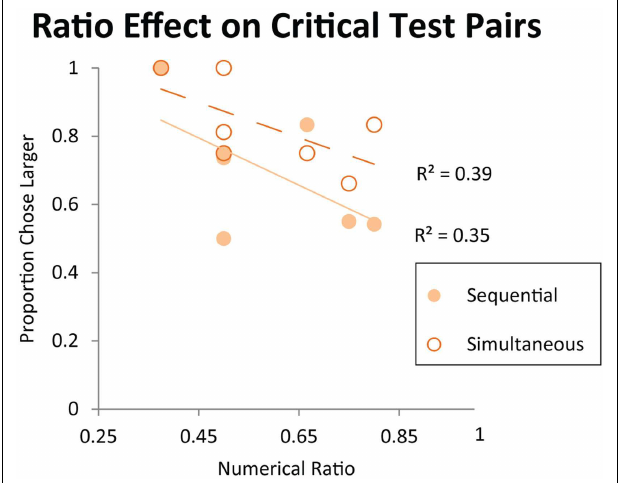
FIGURE 7 | Performance on the critical test pairs for object-file representation: 2 vs. 4, 3 vs.4, 3 vs. 6, 3 vs. 8, 4 vs. 5, 4 vs. 6, 4 vs. 8 . All of these pairs have been reported as failures in monkeys, infants, or both and those failures have been cited in support of the object-file hypothesis (Hauser et al., 2000; Feigenson et al., 2002). Each data point on the graph represents a different numerical pair from this set.Trend lines represent linearly decreasing accuracy as numerical ratio gets finer. Contrary to the predictions of the object-file hypothesis, accuracy on these numerical pairs is modulated by numerical ratio in